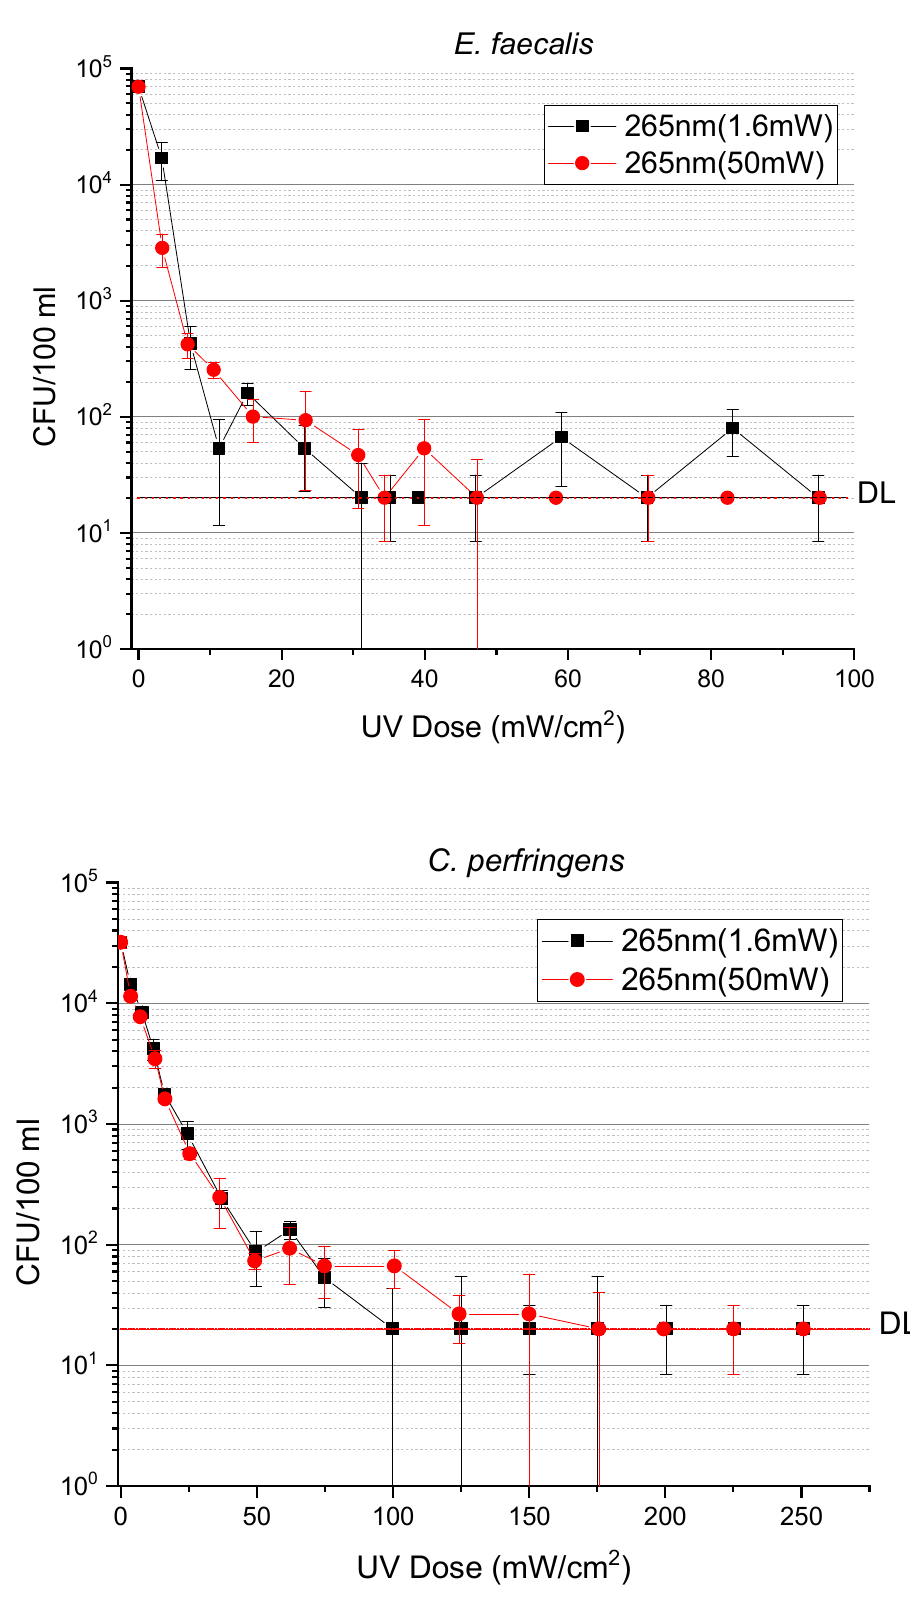
Figure 4. UV-LED disinfection results for E. coli , E. faecalis, and C. perfringens at 265 nm under two different optical power UV-LEDs (2.5 mW and 50 mW) maintaining the same UV dose. The reciprocity law is valid. DL—Detection